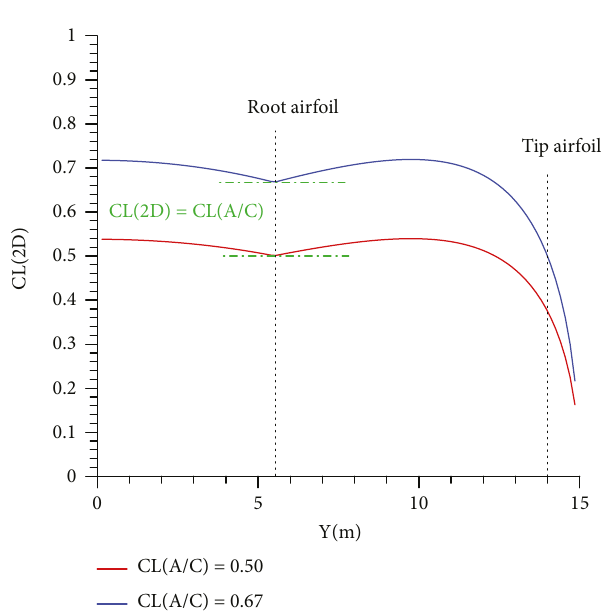
Figure 4: Spanwise evolution of the local lift coe ffi cient for fl ight conditions 1 and 2.